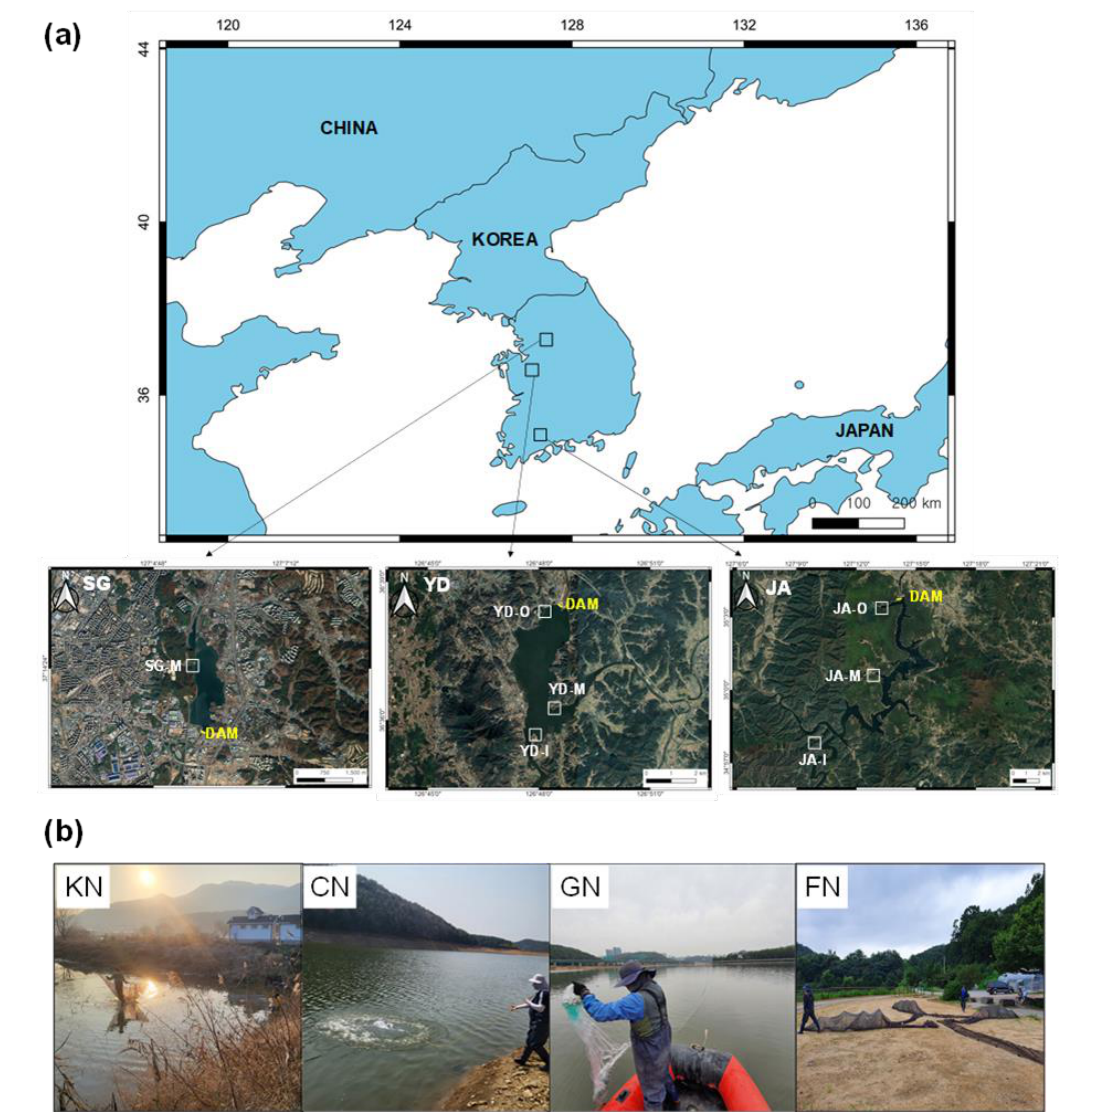
Figure 1. ( a ) A map of the Singal (SG), Yedang (YD), and Juam (JA) reservoirs with the seven